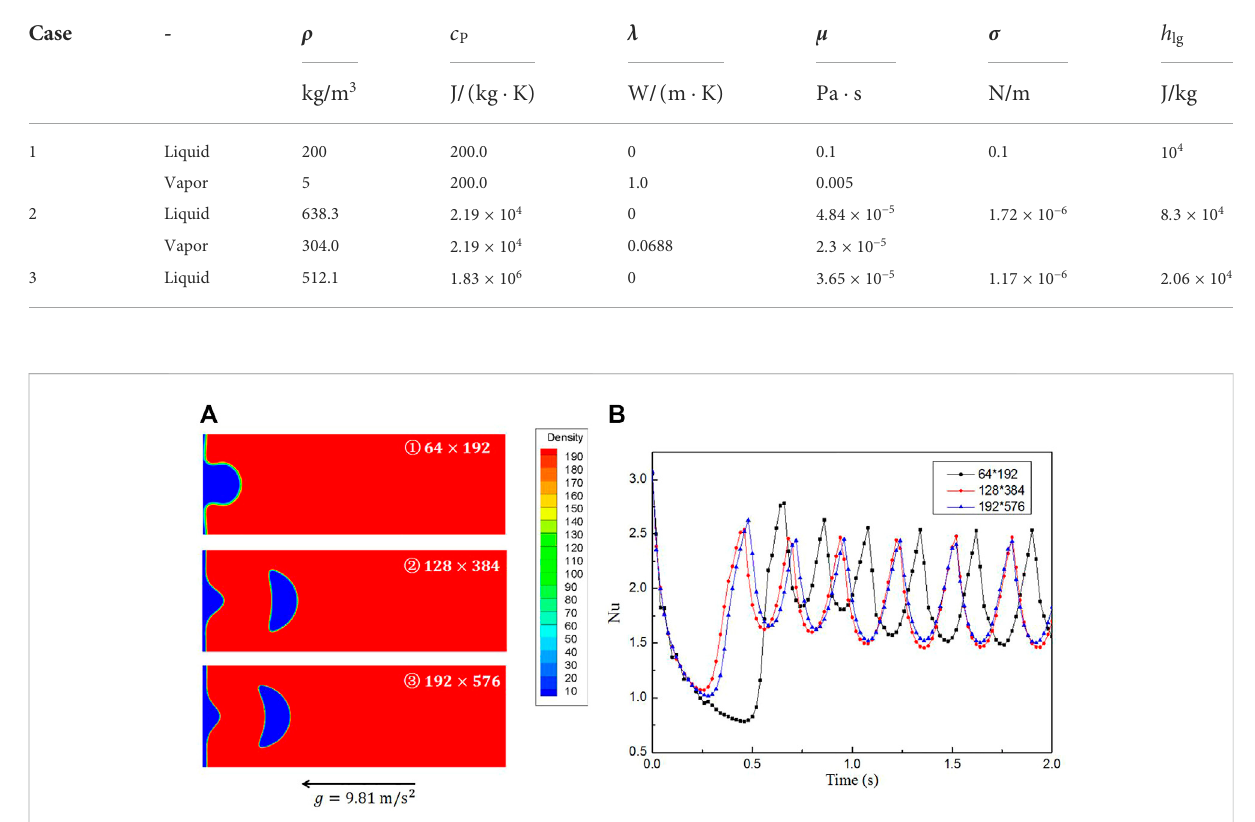
TABLE 2 Properties database for cases 1 – 3.